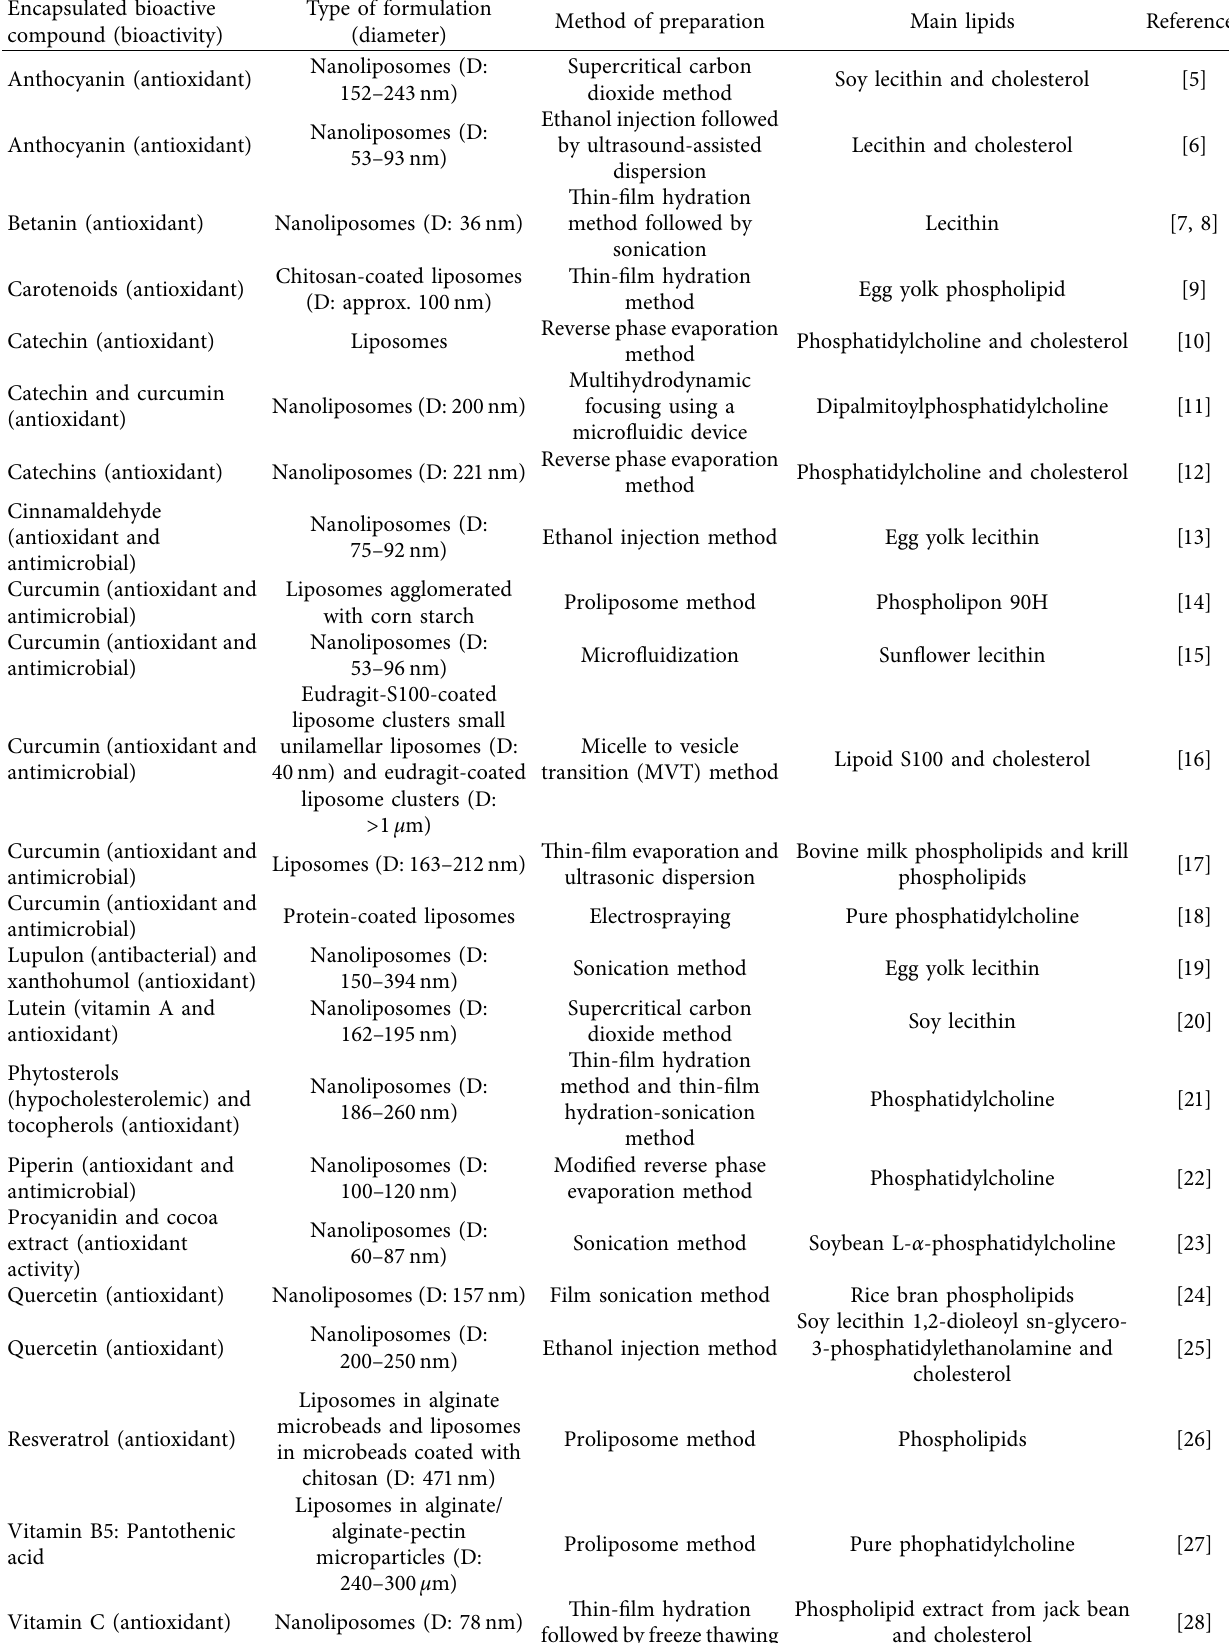
Table 1: Recently reported plant bioactive compound encapsulated liposomal formulations with potential applications in food, methods of preparation, and lipids